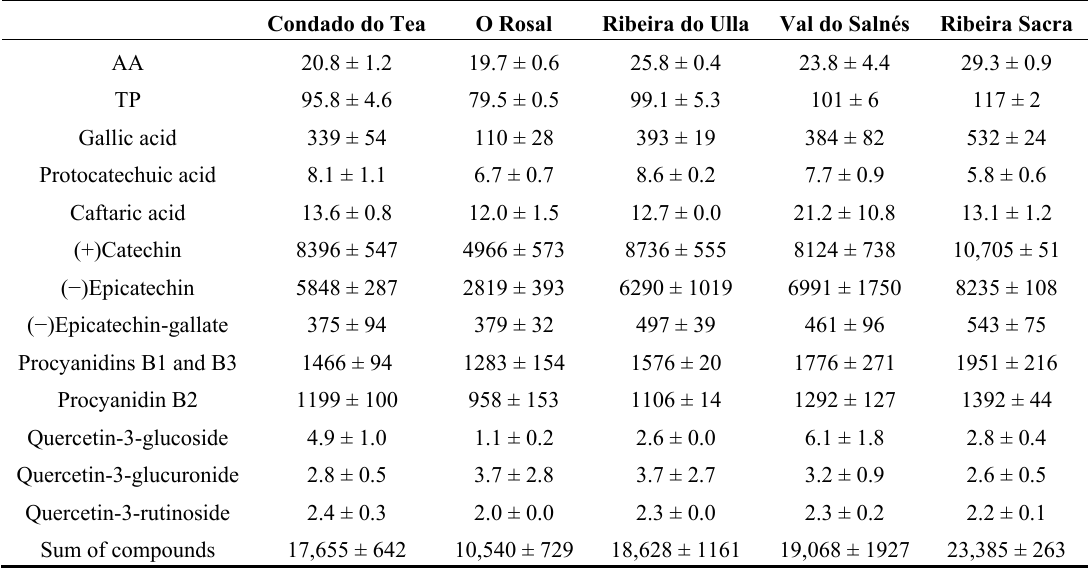
Table 3. Antioxidant activity and polyphenolic composition of Galician varietal Albariño grape seed samples from different origin (mean ± standard deviation, n =